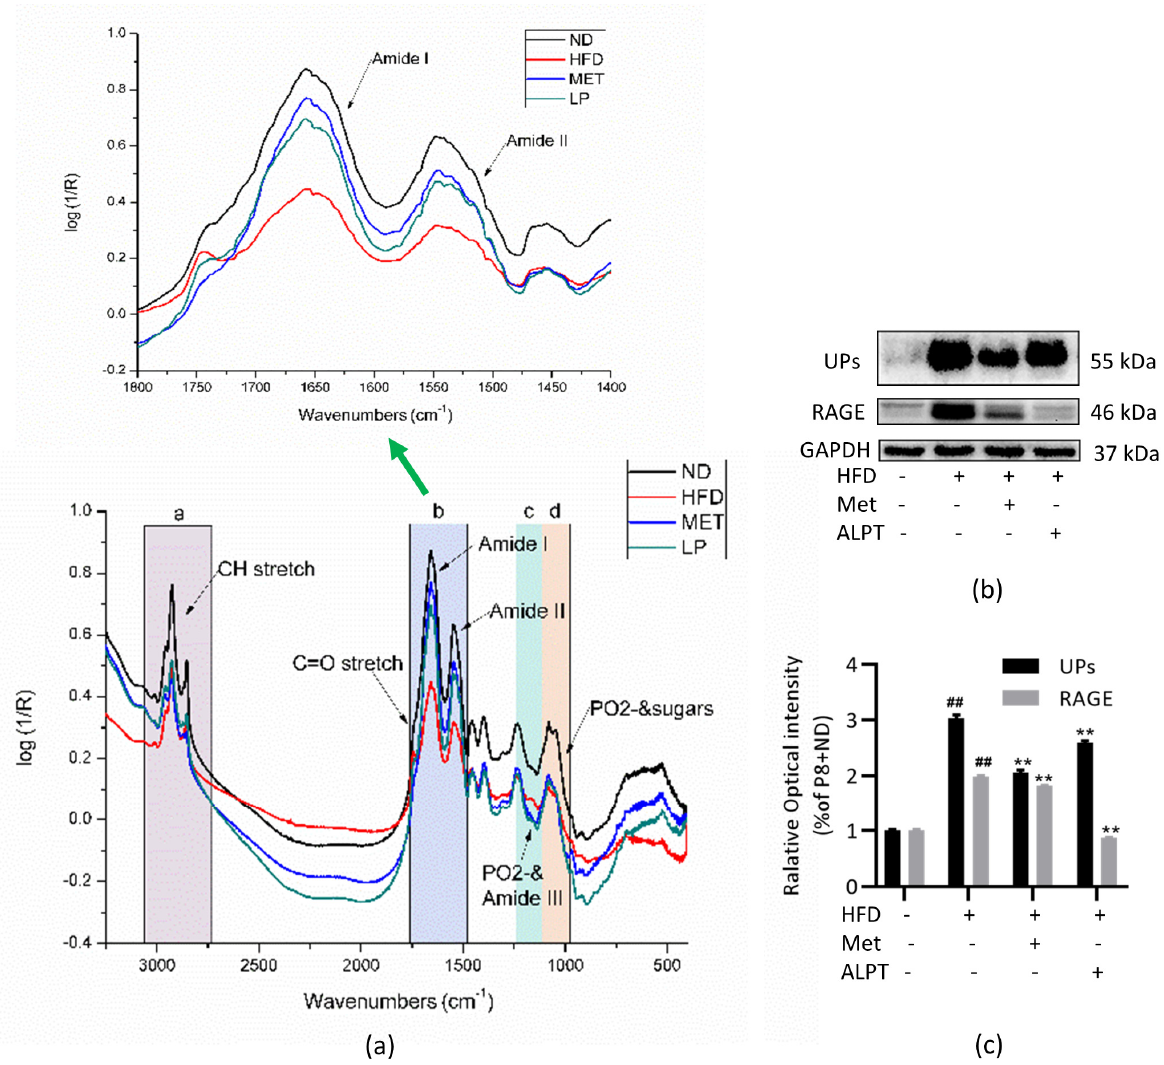
Figure 4. APLT inhibits P8+HFD-induced aggregates formation pathway and biomacromolecule structure alterations. ( a ) Infrared spectra of the liver. ( b , c ) Western blotting detection of ubiquitin- conjugated proteins (Ups) and receptor for advanced glycation end products (RAGE), n = 3. In